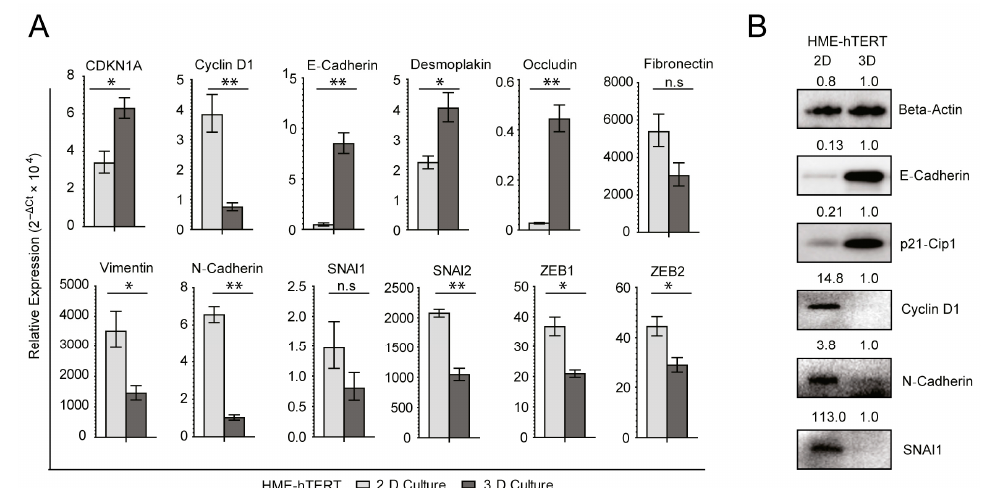
Figure 2. The non-malignant but immortal HME-hTERT cells upregulate the expression of genes associated with epithelial differentiation and cell cycle arrest when transferred from adherent to anchorage-independent soft-agar culture. ( A ) Q-RT-PCR analysis of RNA samples obtained from adherent (2-D culture, light grey bar) and soft-agar (3-D culture, dark grey bar) cultures of HME-hTERT cells of the indicated genes. Statistical significance is reported as p values computed using mean − ∆ Ct values and normalized SD; ** p ≤ 0.01; * p ≤ 0.05; n.s: Not Significant. Data shown are the relative expressions [(2 − ∆ Ct × 10 4 ) ± normalized SD] from duplicate determinations of a single experiment that is representative of three such experiments. ( B ) Immunoblot images and densitometry band intensity analysis of the indicated proteins extracted from HME-hTERT cells cultured in adherent (2D) and soft-agar (3D) conditions. Beta-actin was used as the loading control. The data are representative of three biological repeated